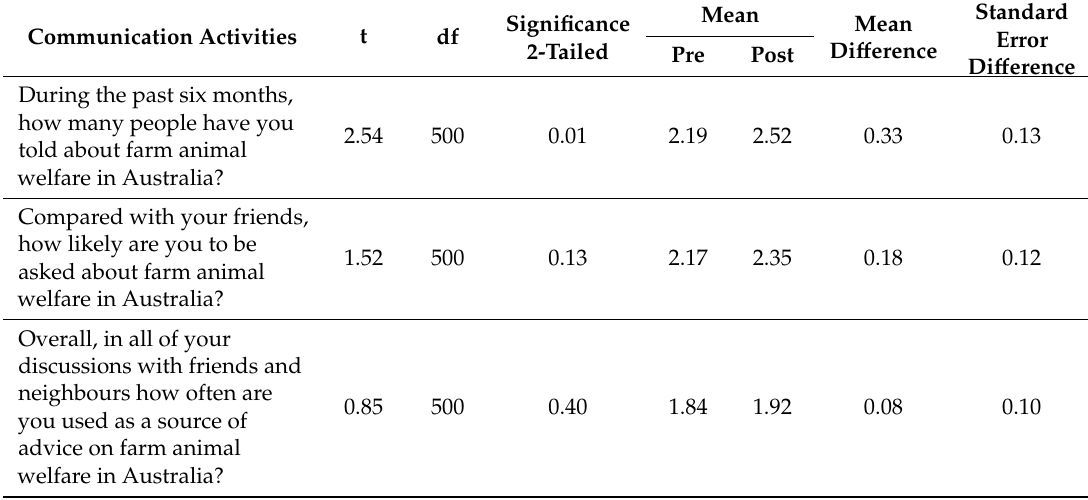
Table 8. Independent t tests comparing the communication activities that respondents engaged in pre and post the 60 Minutes